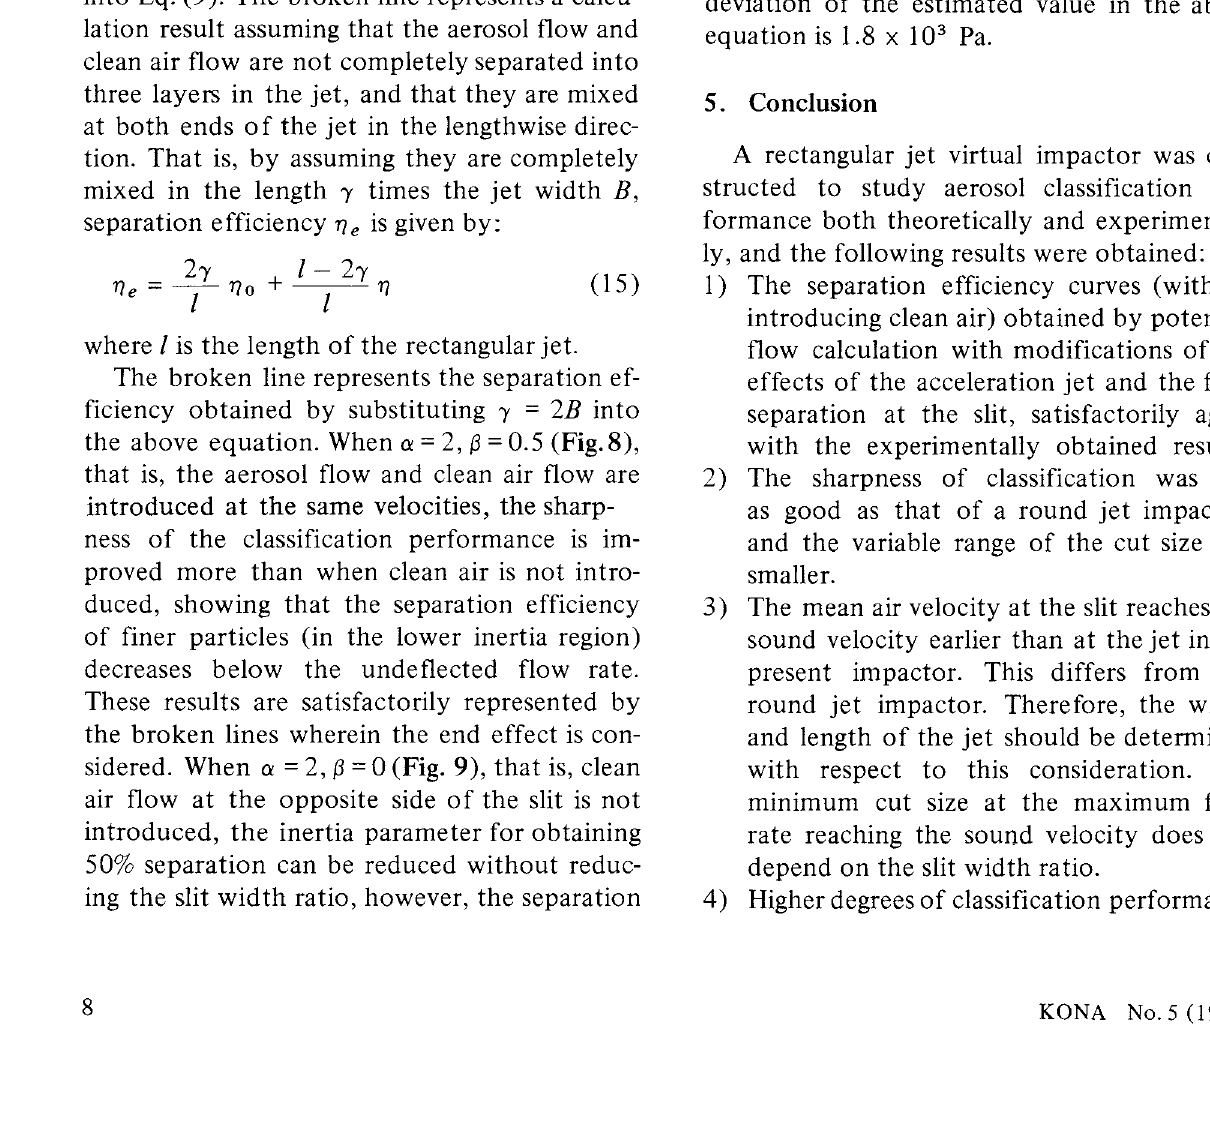
Fig. 9 The effect of clean-air flows on the separation